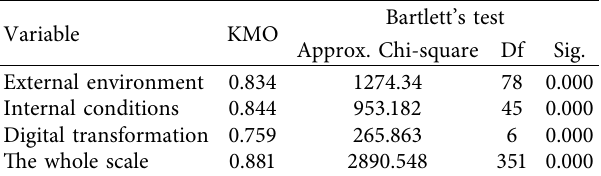
Table 3: Statistical table of variable validity